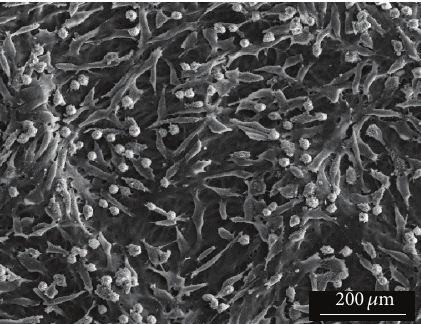
Figure 5: SEM micrographs of proliferation of L929 cells on P(3HB- co -50 mol% 4HB)/15mg